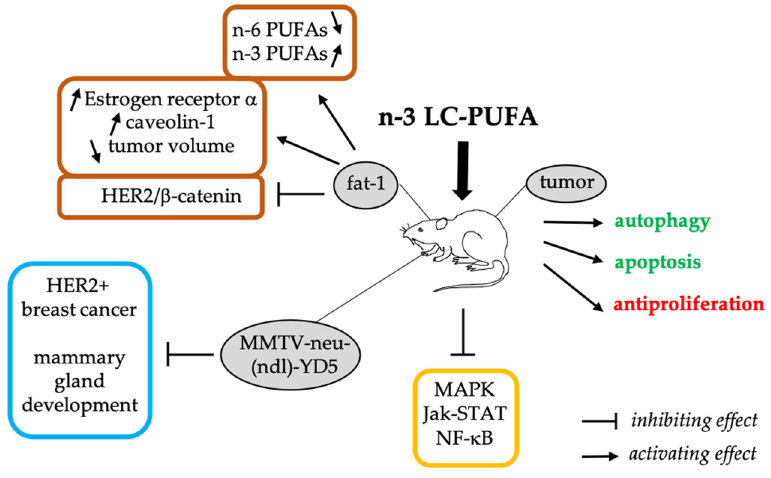
Figure 2. Protective effects of dietary n-3 LC-PUFAs in animal models of breast cancer.